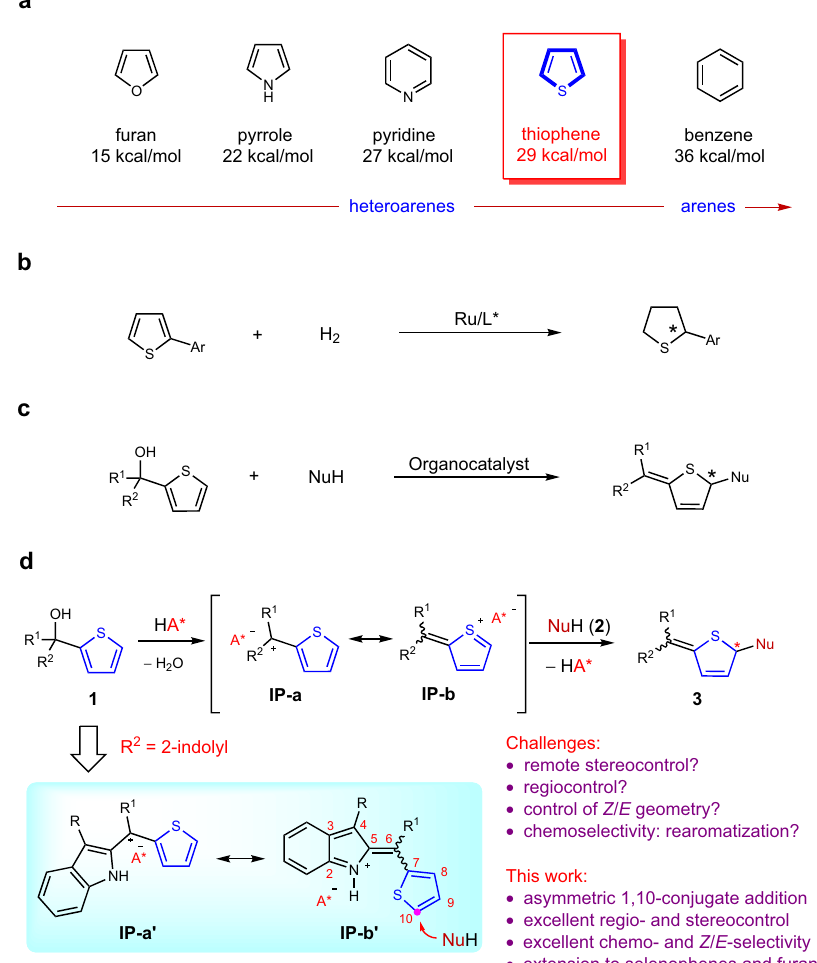
Fig. 1 Asymmetric dearomatization of thiophenes. a Resonance stabilization of simple aromatic compounds. b Metal-catalyzed asymmetric dearomatization of thiophenes (by Glorius). c Organocatalytic asymmetric dearomatization of thiophenes (our strategy). d Our reaction design and the challenges (this